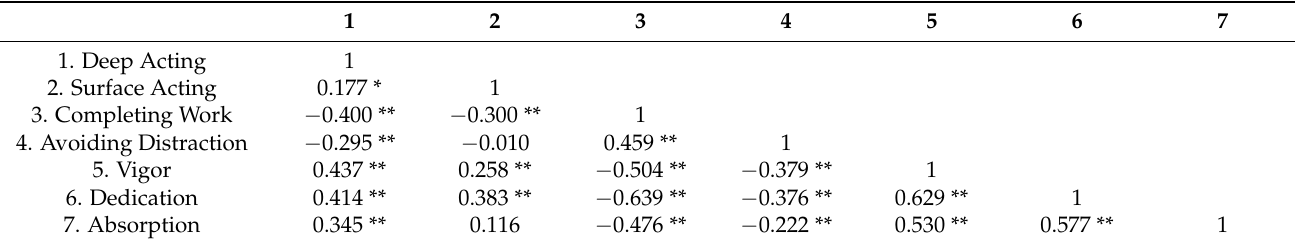
Table 4. Correlation